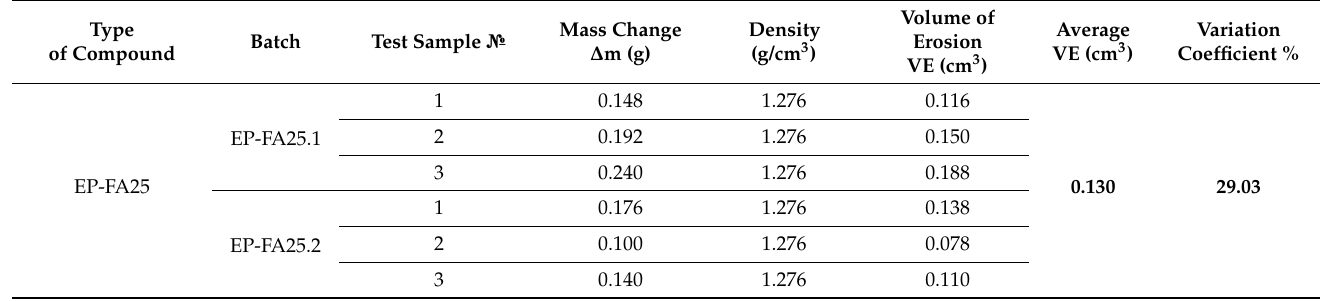
Table A11. Wear of filled epoxy binder (EP-FA25) at 180 ◦ C at an impingement angle of 90 ◦